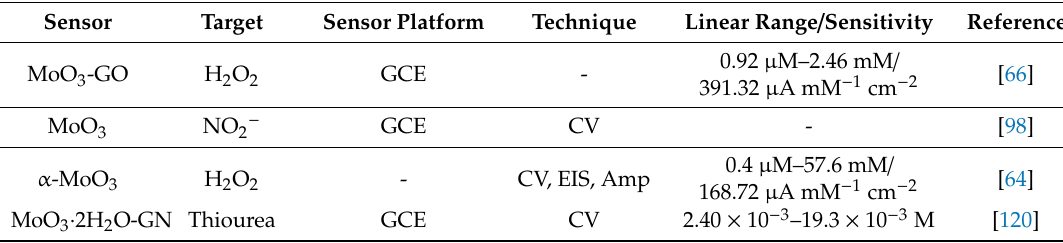
Table 2. 2D Mo-oxide sensors.